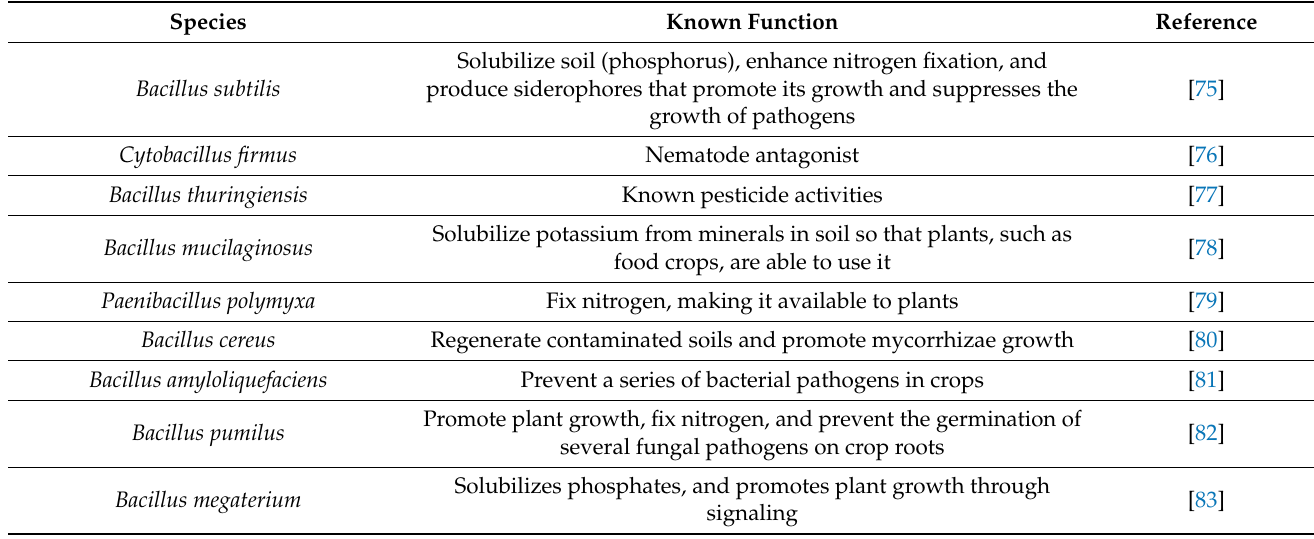
Table 4. A list of Bacillus family species and their application in agriculture for ATGC